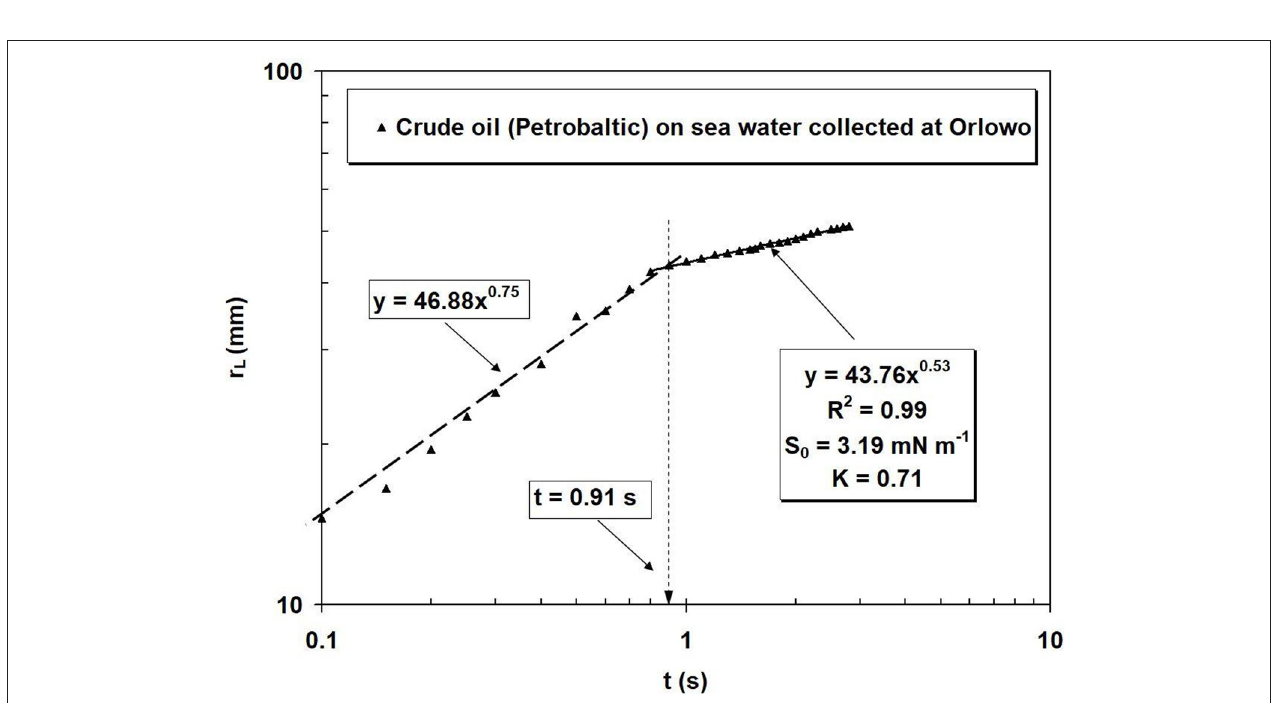
FIGURE 4 | Radius r L vs. time for 1 mm 3 m volume crude oil (Petrobaltic) drop on sea water collected at Orlowo (Gulf of Gdansk, Baltic Sea). The solid line (–) corresponds to the time dependence with n = 3/4, whereas the dashed (----) one results from the best-fit least-squares approximation applied to the experimental data. A vertical line points to the “switch over” time, at which the transition from “nonvolatile” to “volatile” spreading regime starts.